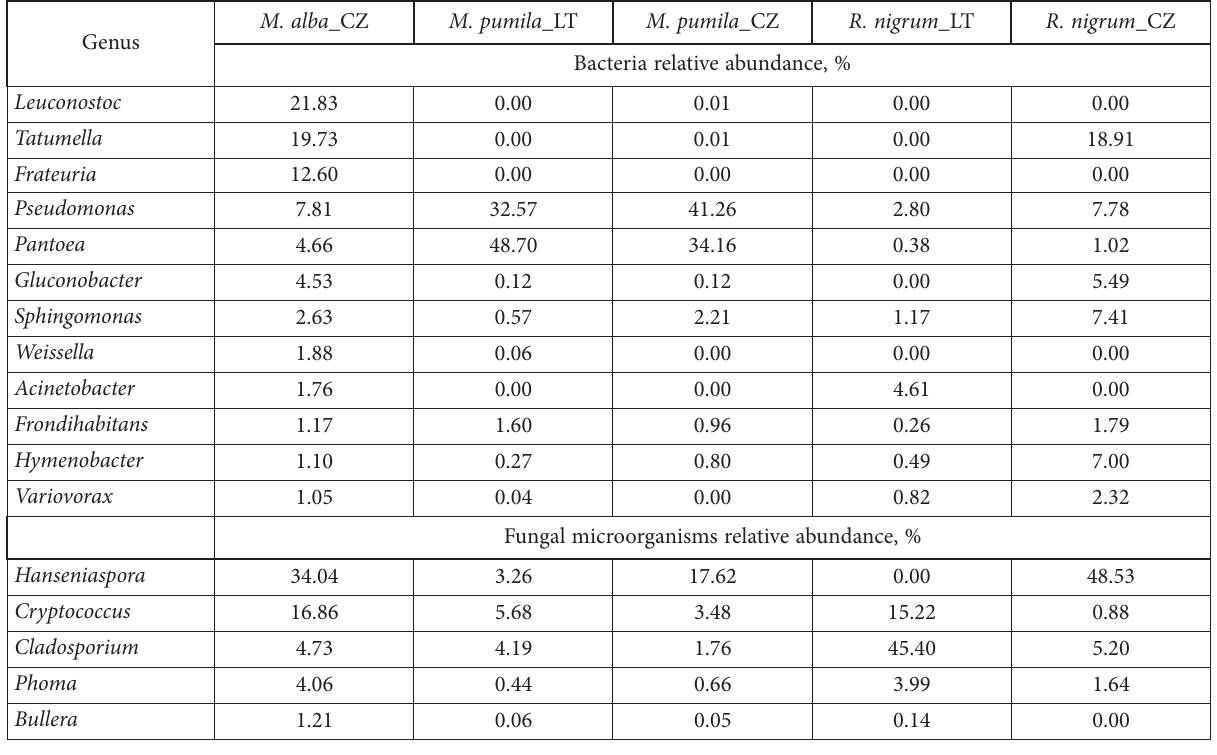
Table 3. Most abundant bacterial and fungal microorganisms on the Morus alba carposphere in comparison to those on Malus pumila and Ribes nigrum . Taxonomy analyzed at genus level. Cz -fruits collected in Czech Republic, LT – in Lithuania. Data on distribution of apple and blackcurrant microbiota obtained from Vepštaitė-Monstavičė et al.